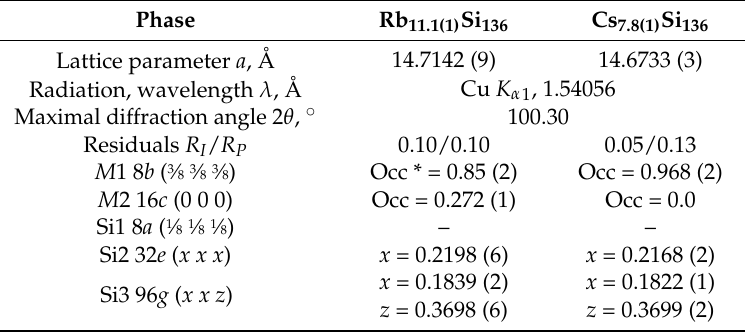
Table 3. Crystallographic information on the clathrate-II phases prepared by SPS (PXRD